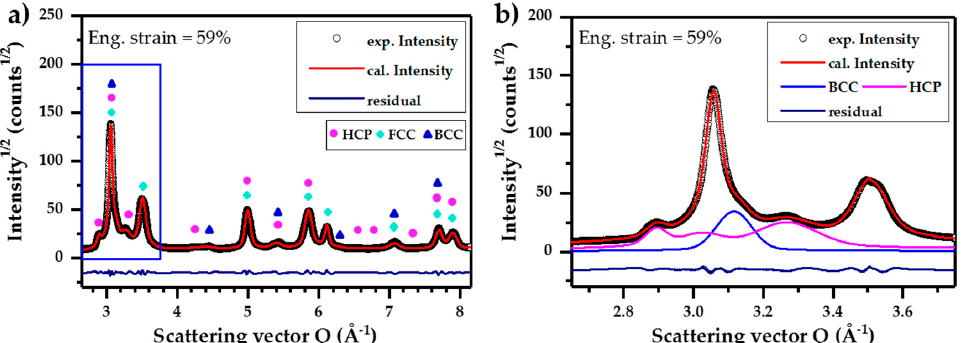
Figure 5. The SYXRD profile of the Fe-17Mn-1.5Al-0.3C steel at fracture ( ε = 59%) fitted by the Rietveld refinement method using MAUD software: ( a ) full profile and ( b ) zoom-in of the region marked in (a) showing the fitted curves of the individual phases.